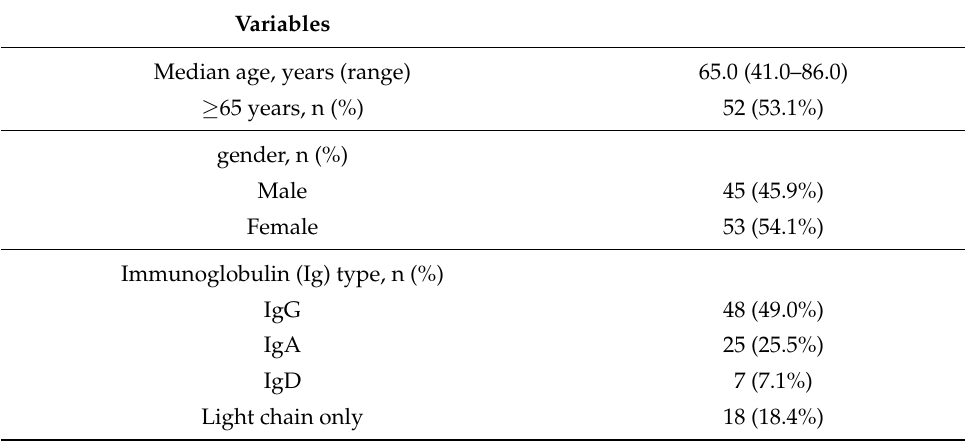
Table 1. Baseline clinical characteristics of all patients (n =